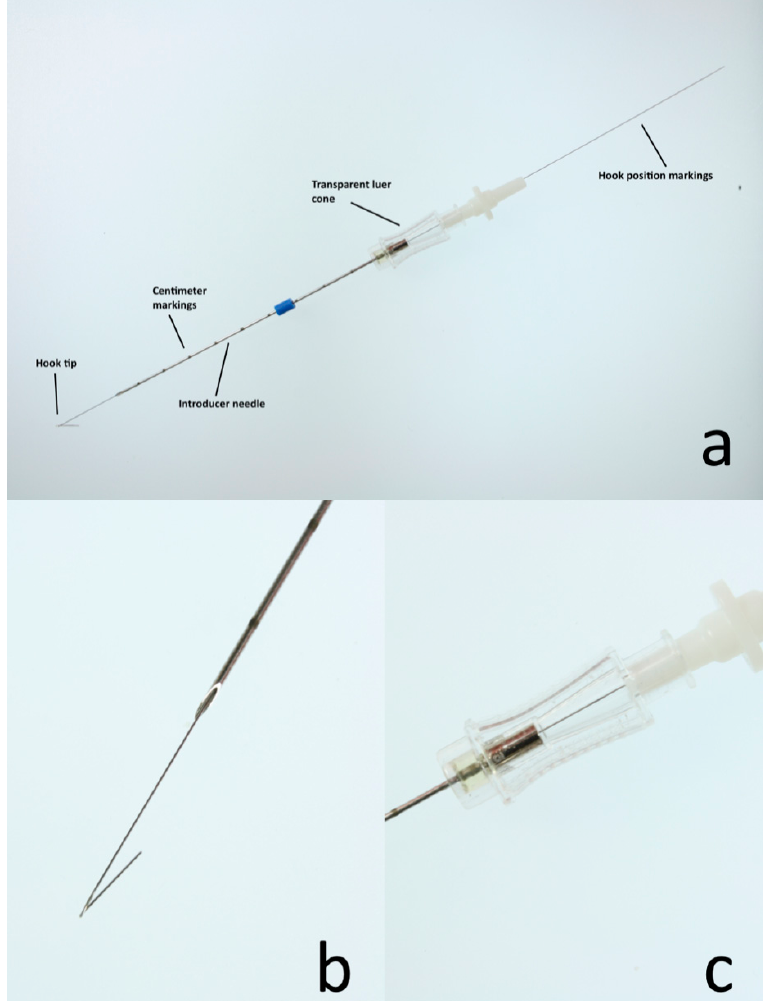
Figure 1. ( a ): The figure shows a non-repositionable localization hook-wire needle used in the present study. ( a ): The hook tip securely keeps the device in place. The localization needle has centimeter markings for greater precision. The luer cone facilitates the wire insertion and allows the detection of the black mark on the wire to indicate the hook position. ( b ): Higher magnification of the hook tip. ( c ): Higher magnification of the luer cone.